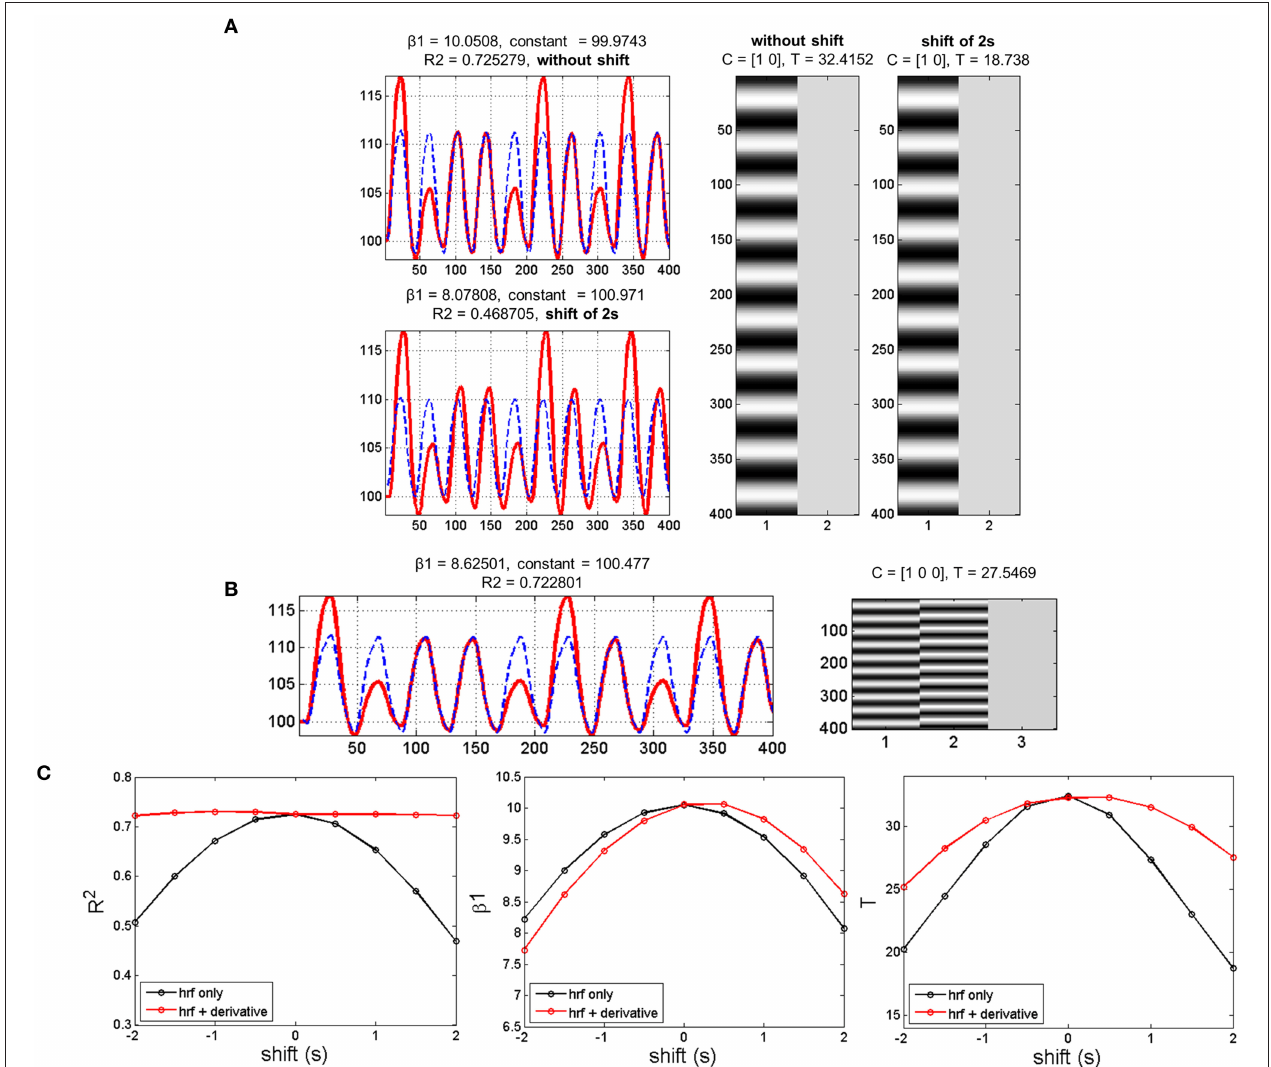
FIGURE 2 | Simulation results with data mimicking a periodic event related design. (A) Data modeling using the HRF alone while adding or not a temporal shift of 2s between the model (blue dashed lines) and the simulated data (red lines). Adding a temporal shift deteriorates the model fit (R 2 ), the canonical HRF estimate ( β 1) and the T-score. (B) Data modeling using the HRF plus its first derivative while adding a temporal shift of 2s between the model (blue dashed lines) and the shifted data (red lines). Adding the derivative improves substantially R 2 and to a lower extent T-score, but has very limited impact on β 1. (C) Variations in temporal shift from -2 to 2s confirmed the previous observation, with the largest effect of including the first derivative being on R 2 and the poorest effect being on β